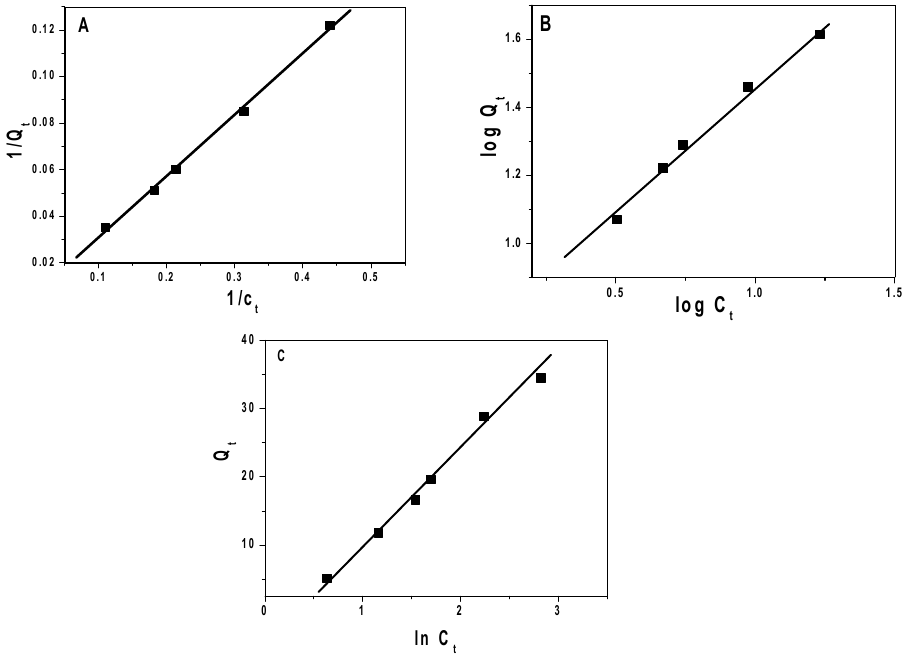
Figure 9. ( A ) Langmuir, ( B ) Freundlich, and ( C ) Temkin isotherms for mercury removal using CuFe 2 O 4 /PANi nano-composite.